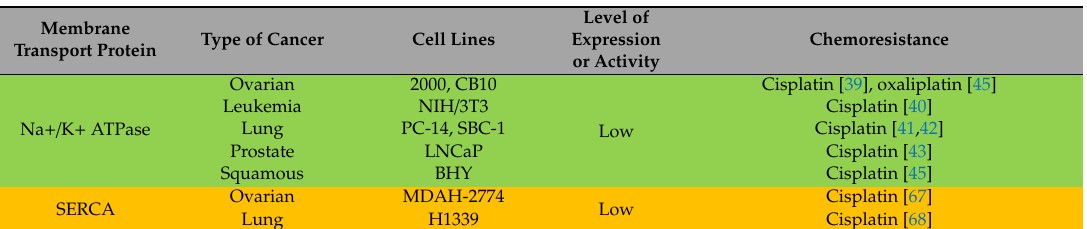
Table A1. Summary of membrane transporter proteins in various cancers, their expression profile, and their role in chemotherapeutic